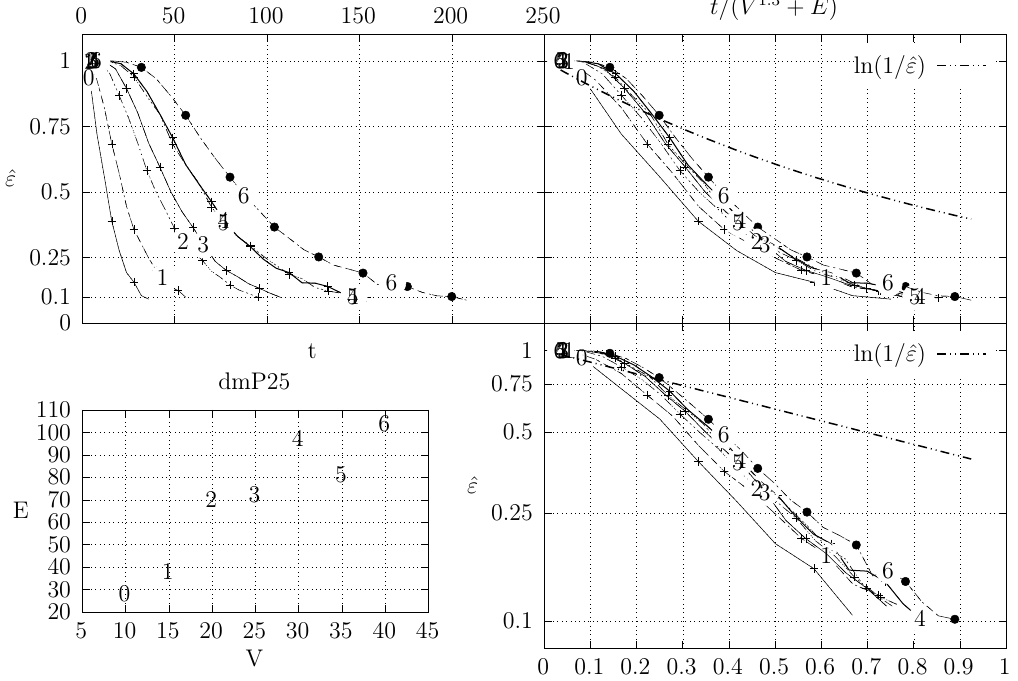
Figure 23. Estimation of variation distance as a function of the number of iterations for dmP graphs (see Section 4.3.1 for details).